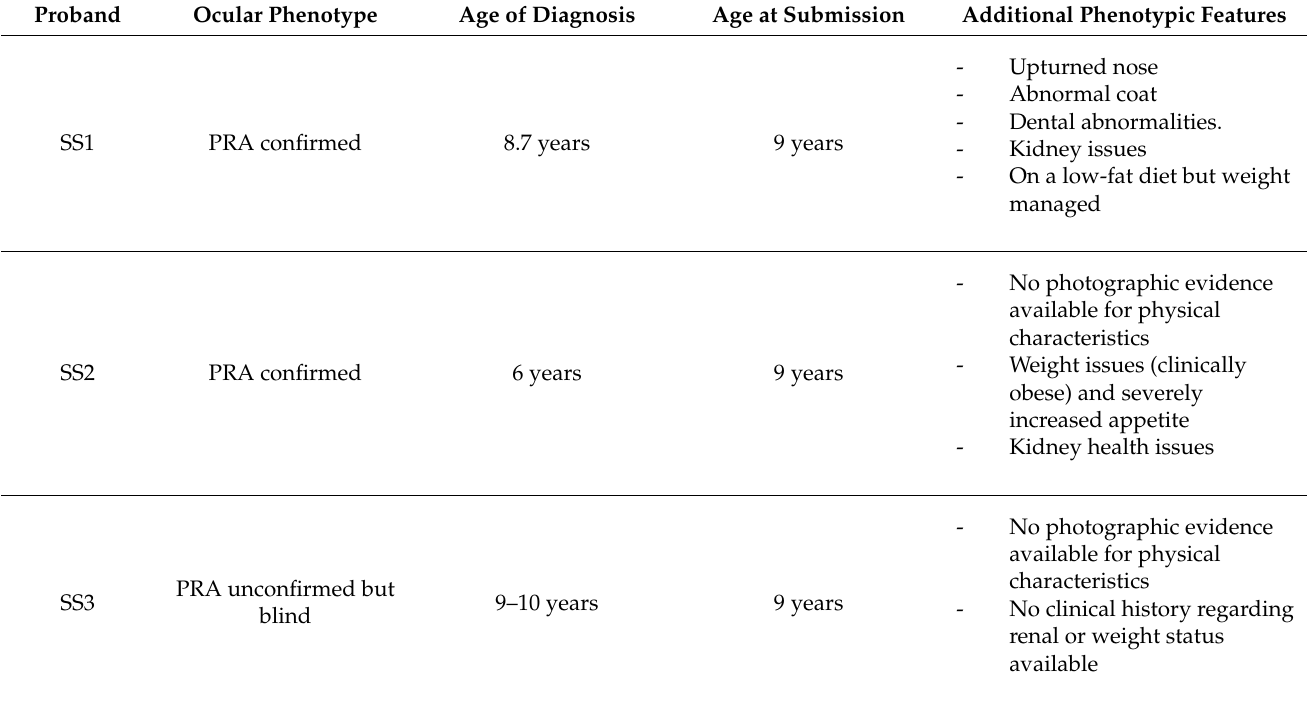
Table 4. Summary of the SS homozygous for the BBS2 c.1222G>C variant and their